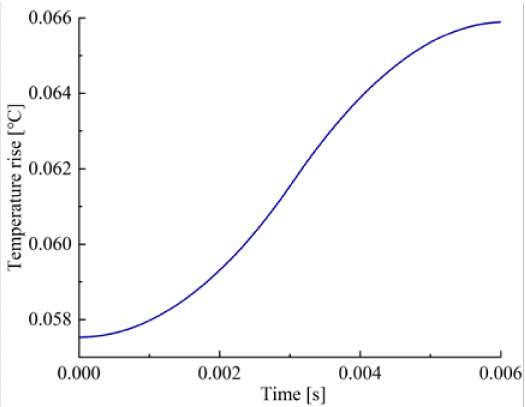
Figure 7. Variations in the temperature rise of the oil in the sealed cavity of the oil suction